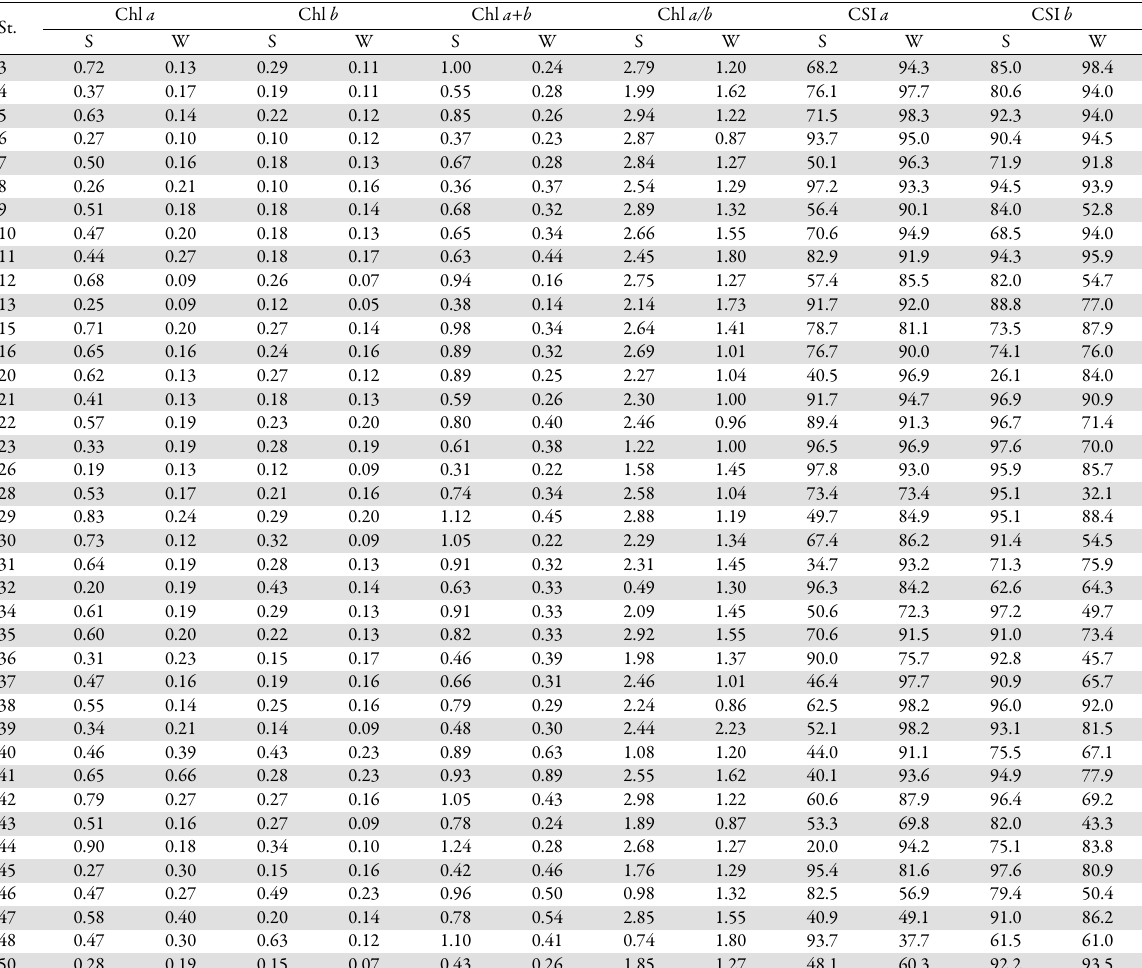
Table 3. Chlorophyll (Chl a , Chl b and Chl a + b ) concentrations (mg g -1 f. wt.), chlorophyll a/b ratio and chlorophyll stability index (CSI , %) at different stands inhabited by Zilla spinosa plants, in summer and winter